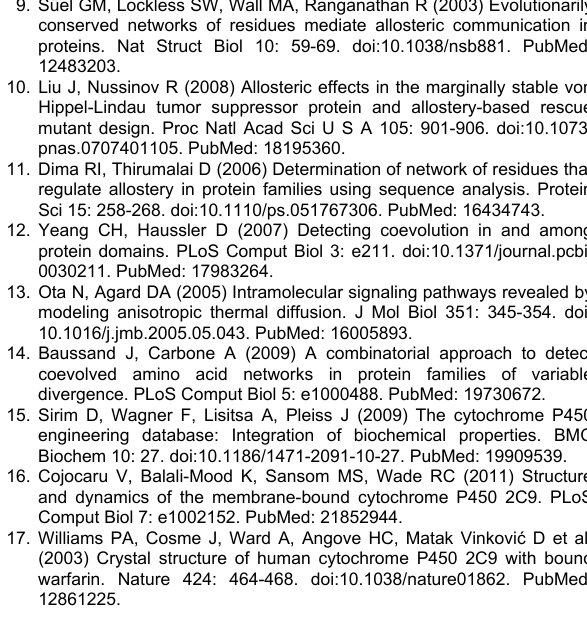
Figure S6. The second trajectories of comparison of root mean square fluctuations (ΔRMSFs) from anisotropic thermal diffusion simulation of naturally occurring mutants with wild-type (WT) CYP3A4: M445T (A), F189S (B), I118V (C), and L293P (D). Key residues 301-306 are highlighted by blue ovals. All residue numbers refer to the CYP3A4 sequence (PDB code 1W0E).